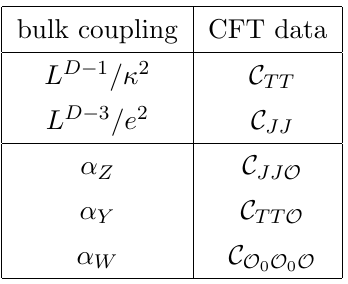
Table 3 . The couplings in the holographic model (3.1) are related to the CFT data of its dual theory. Here we have listed the qualitative connection between certain dimensionless numbers associated with (3.1) and CFT data of interest for our computation. One thing missing from this table is | this is related to the normalization of the kinetic term for (cid:8) in (3.1), which we have C OO set to 1 as per 2